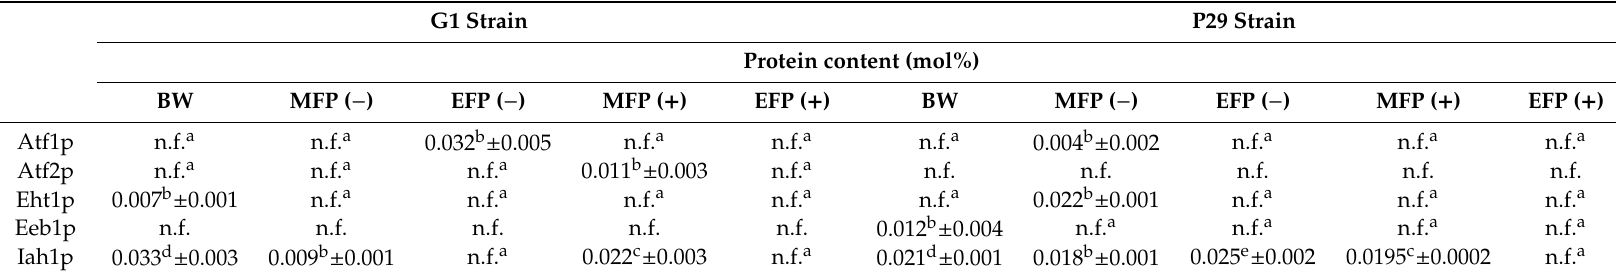
Table 3. Determination of protein content (mol%) by the abundance index (EmPAI) of the proteins identified in each condition related to the esters